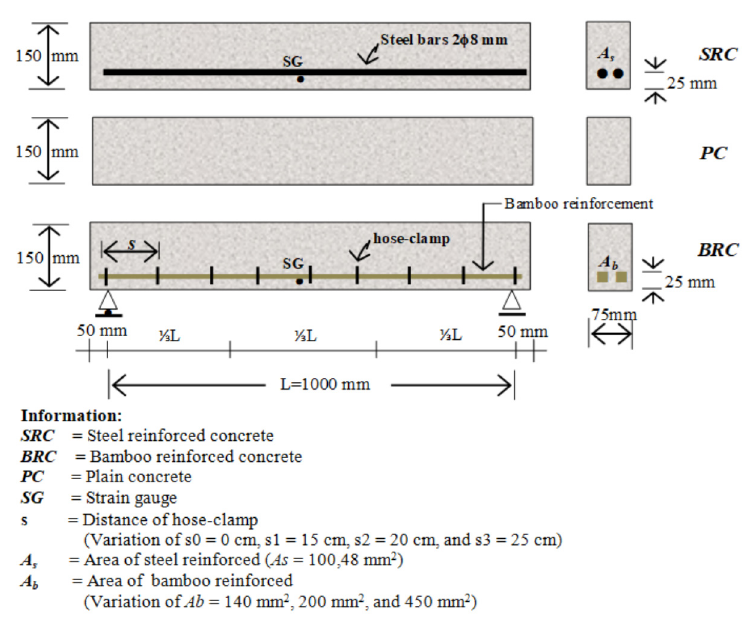
Figure 3. Geometry and details of bamboo-reinforced concrete beams.